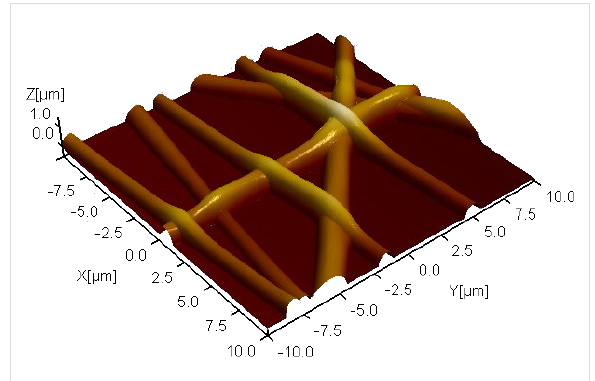
Figure 1: Topography of electrospun silk fibers on a glass substrate. The 3-D image is rendered according to the local height measured by the atomic force microscope. The scan size is 20 × 20 µm 2 . The fibers form a mesh-like network. Branches between intersections occasion- ally form suspended fibers, allowing us to investigate their mechanical